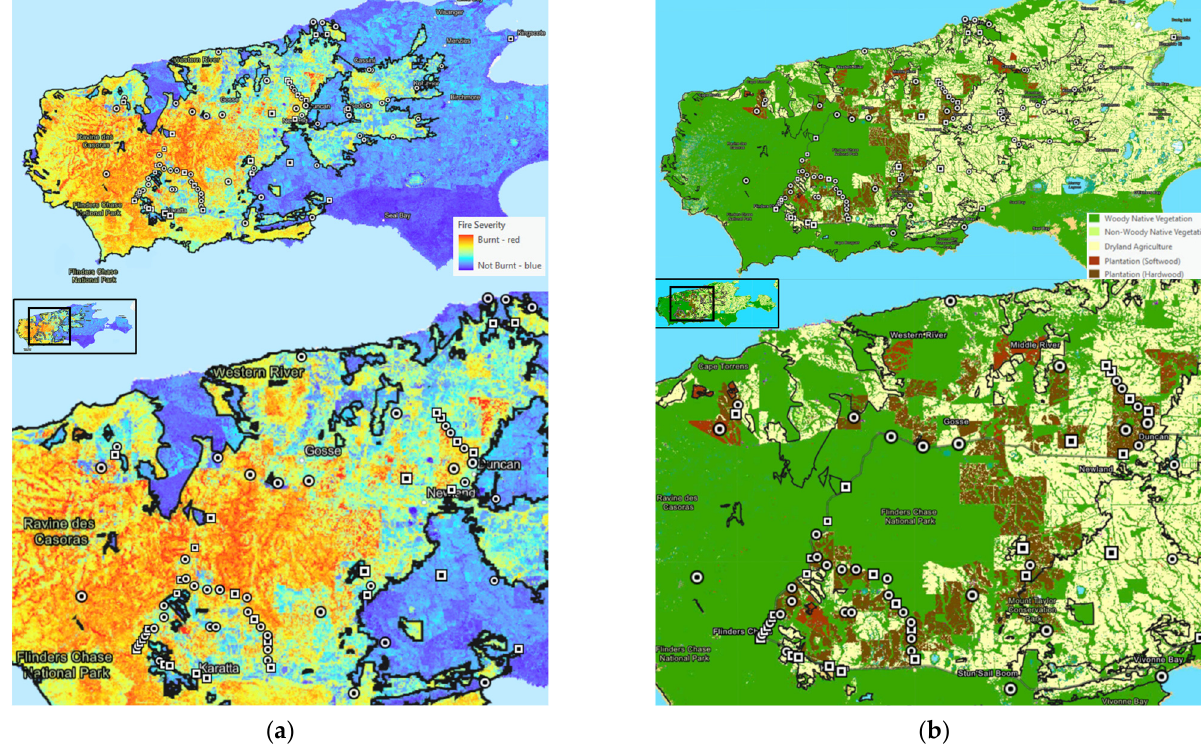
Figure 2. Map of Kangaroo Island created using Google Earth Pro v7.3.4 software to show recorded locations of koalas with burns (circle) and without burns (square) rescued from the 2019–2020 bushfires, and overlaid with adapted images developed by Department for Environment and Water, Government of South Australia [4] from base maps at data.sa.gov.au under Creative Commons Attribution 4.0 licence, demonstrating: ( a ) fire ground and fire severity, and ( b ) fire ground and vegetation type. Box in inset refers to area shown in enlarged (lower) maps.